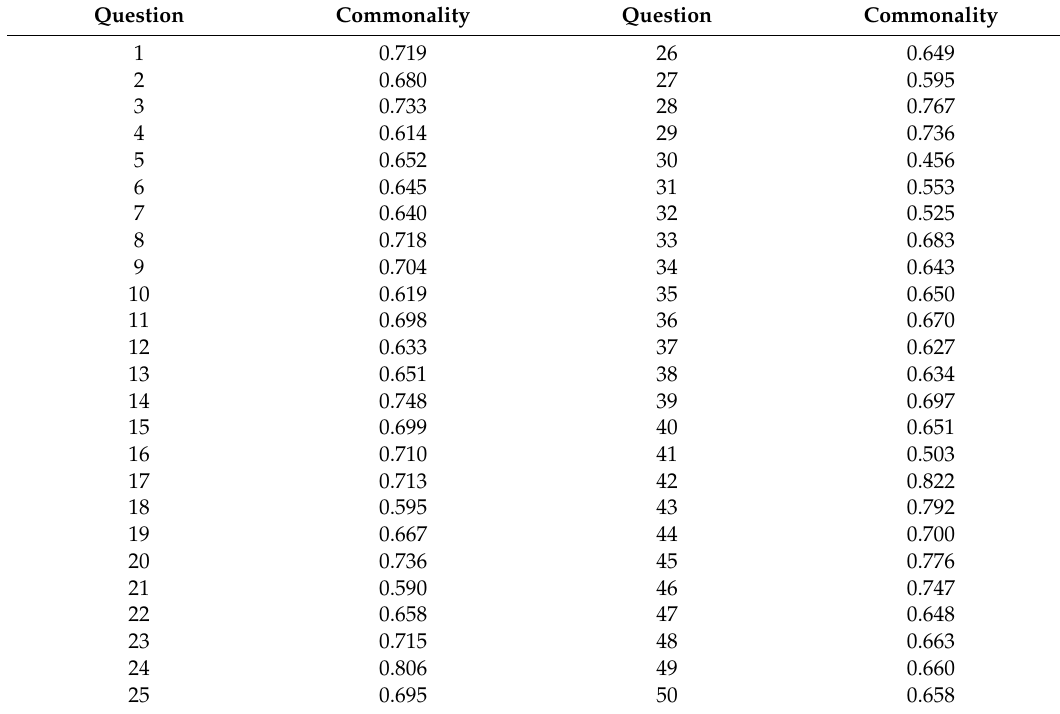
Table 2. Exploratory question analysis for one